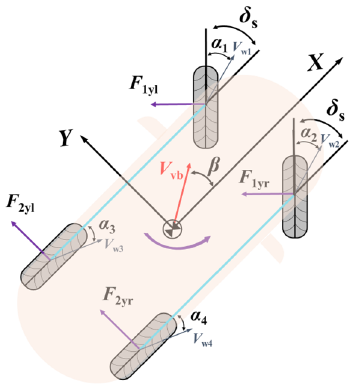
Figure 2. Vertical view of vehicle model on curve segments.